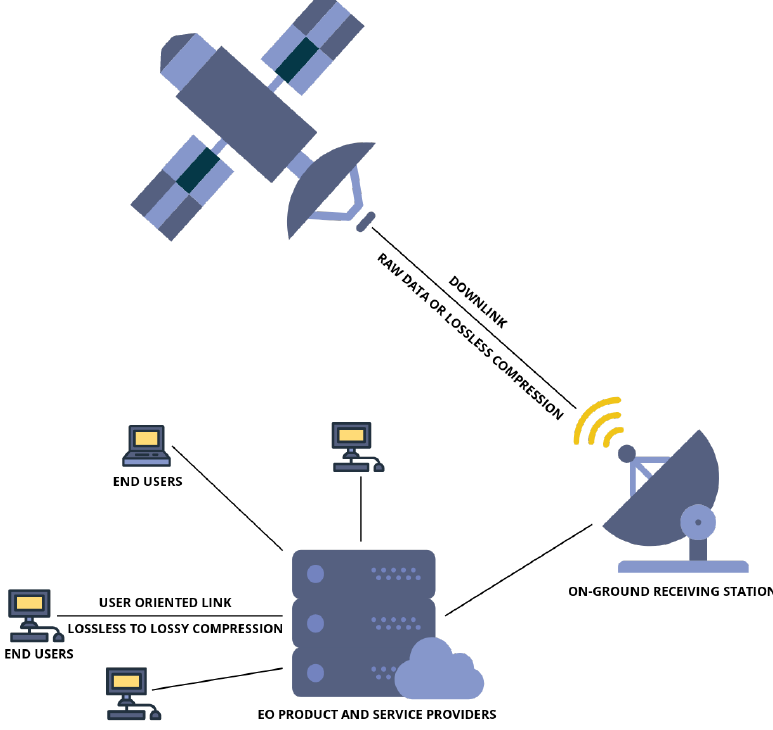
Figure 1. General scheme of Earth Observation (EO) communication and data distribution